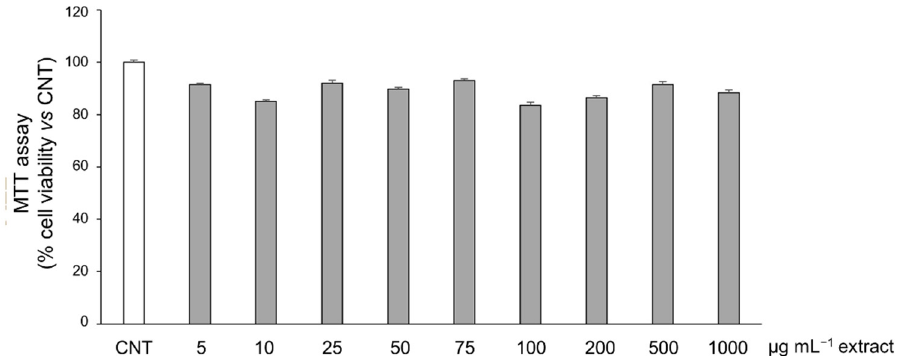
Figure 5. Percentage of viability of HT-29 cells incubated for 24 h in the presence of increasing (5–1000 μ g mL − 1 ) of Salicornia extract. Data represent the mean ± SE ( n = 4). No statistically significant differences were found according to one-way ANOVA followed by Tukey’s test ( p ≤ 0.05).